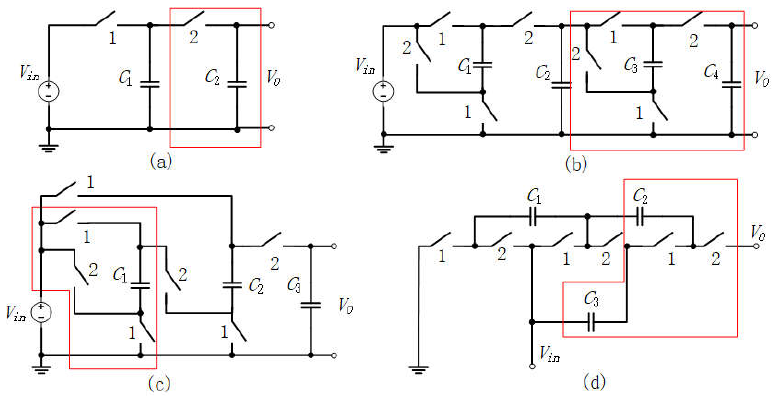
Figure 14. Basic charge pump and switched capacitor circuits. ( a ) Basic charge pump. ( b ) Doubler. ( c ) Series parallel. ( d ) Ladder.